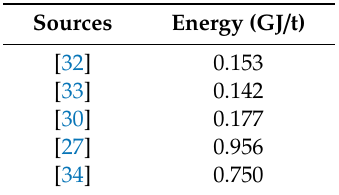
Table 5. Iron ore mining and concentration energy per ton of iron ore.